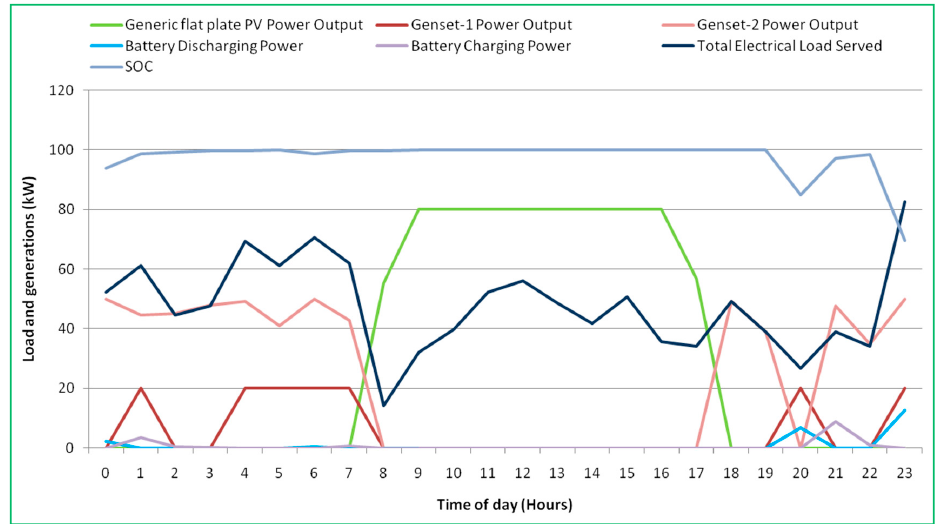
Figure 10. Load and generation in a typical day of the dry season for the best combination of Case-3.